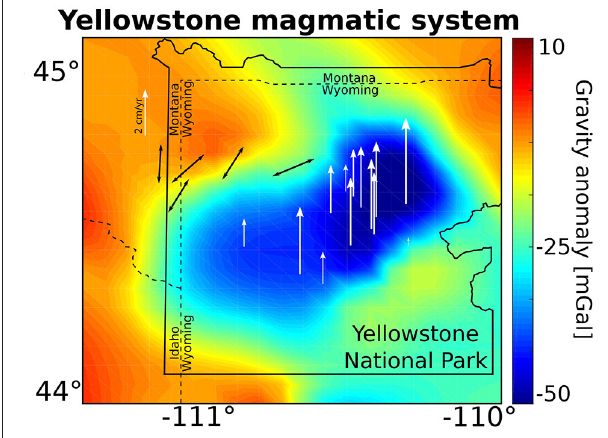
FIGURE 1 | Overview of some geophysical data for Yellowstone used in this work. The area corresponds to the computational domain presented in this work. Colors indicate the bouguer gravity anomaly in the area referenced to the anomaly close to the boundary of the area. Data is taken from the online archive of the Pan American Center for Earth and Environmental Sciences (PACES) and DeNosaquo et al. (2009). White vertical arrows indicate the GPS velocities during a period of high activity from 2003 to 2008 (Vasco et al., 2007). Black arrows represent the orientation of the minimum principal stress ( σ 3 ) (taken from Waite and Smith (2004) and references